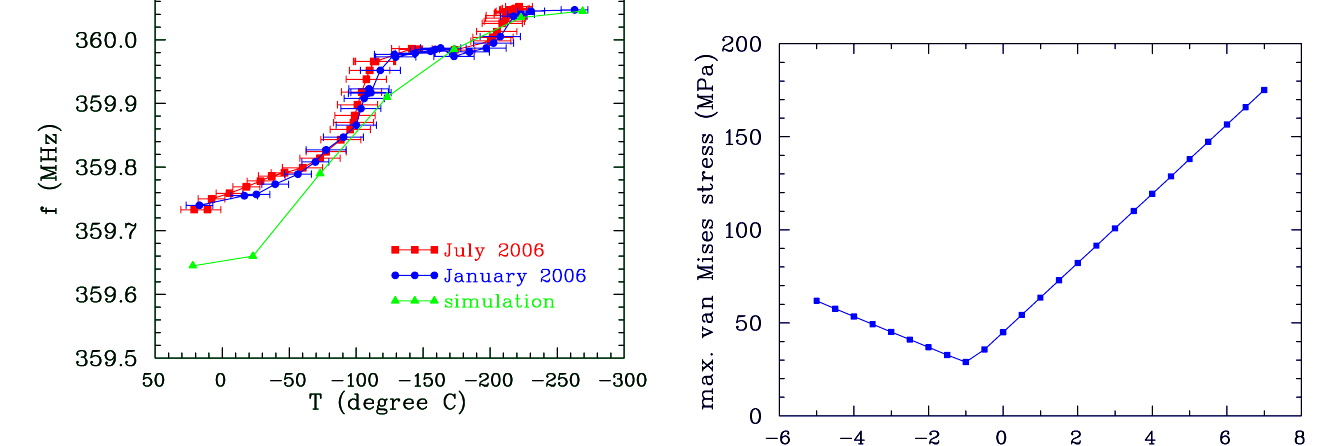
FIG. 38. (Color) Measured (red, blue) and simulated frequency shift during the cooldown. The frequency shift during different cooldowns was very reproducible.